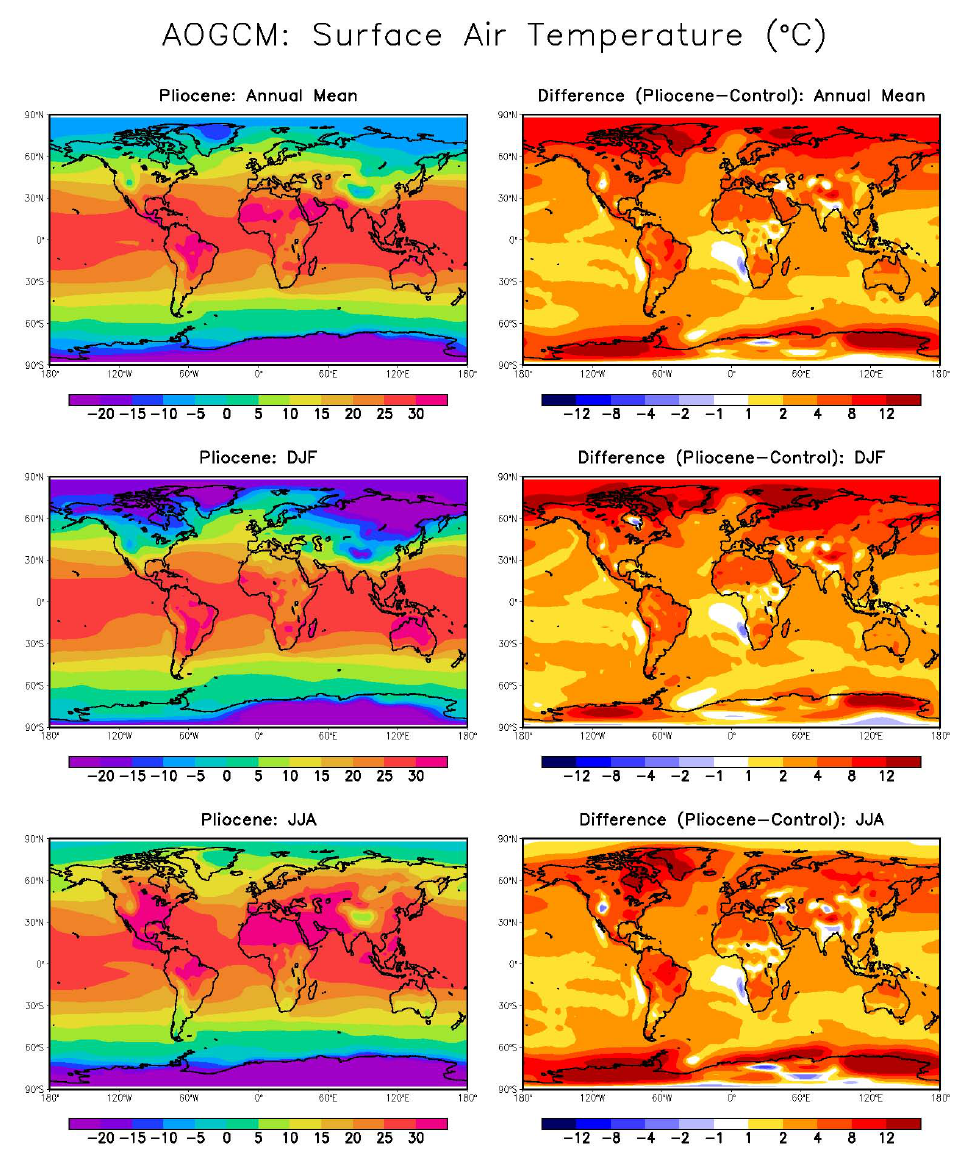
Fig. 10. AOGCM mid-Pliocene surface air temperature averaged over the entire year, December-January-February and June-July-August (left side), and the differences between these values and those of the control experiment (right side).